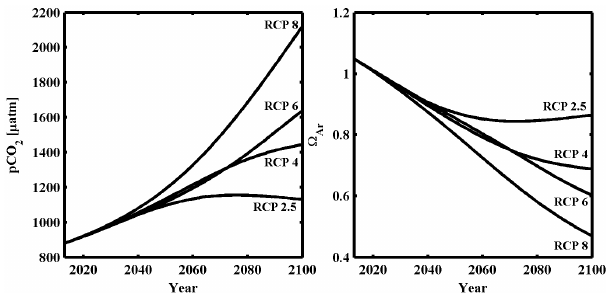
Figure 14. Projections of mean p CO 2 (left) and (cid:127) Ar (right) at the shelf break (88m) based on four projections from the Fifth Assess- ment of the